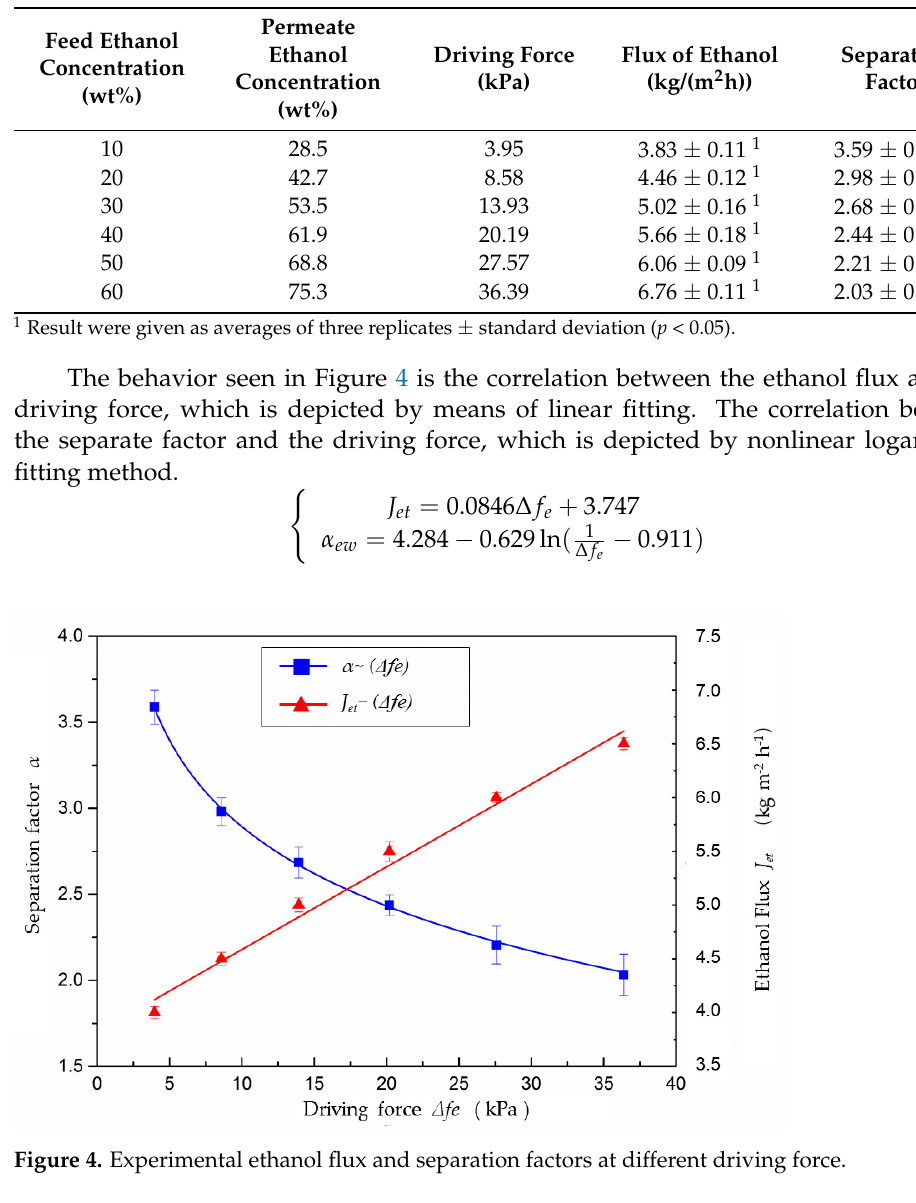
Table 1. VP experimental results in different feed ethanol concentration.